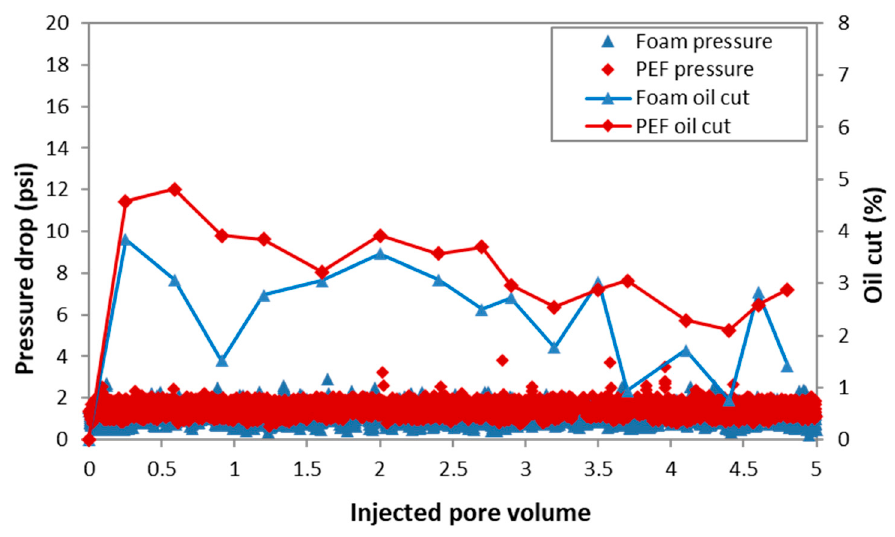
Figure 8. Overall pressure drop and oil cut profile during CO 2 foam and CO 2 PEF injection in the fractured sandstone rock sample. No significant pressure (i.e., apparent viscosity) was observed in the fractured rock.